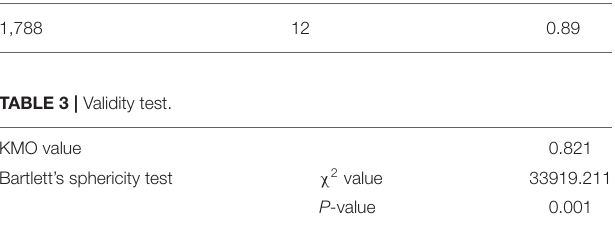
population standard: sports population = 1 and non-sports population = 0 ( Table 1 ).